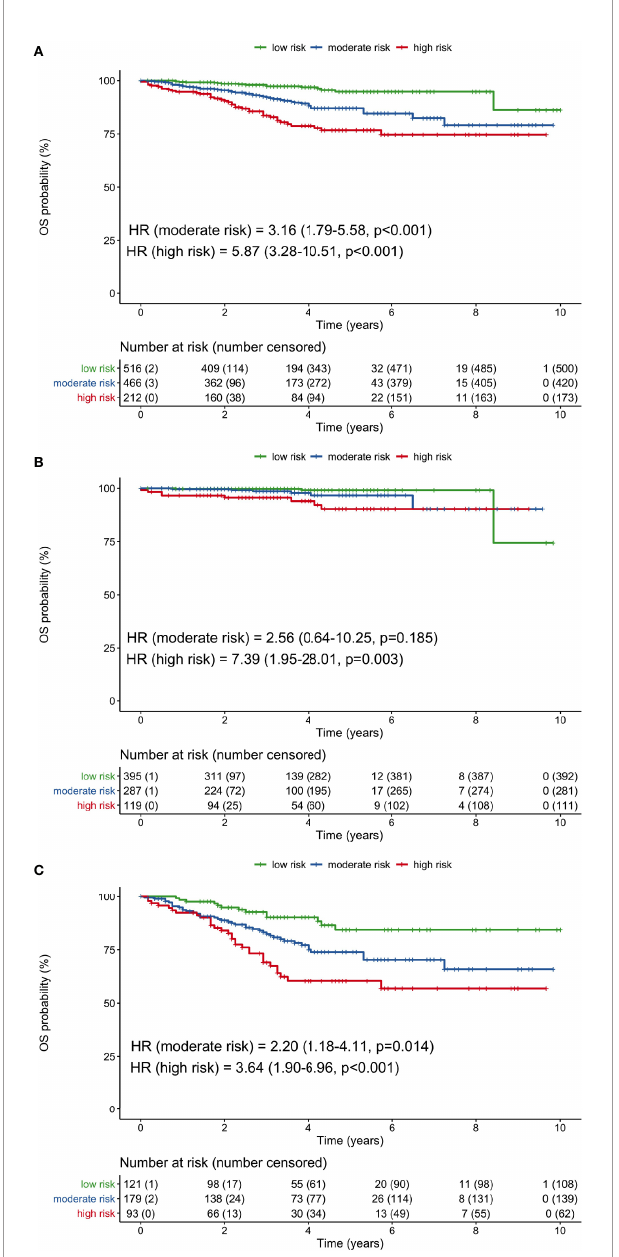
FIGURE 4 | Overall survival curves for low-, moderate-, and high-risk groups based on the combination of 1-month neutrophil and albumin values. (A) all patients, (B) stage I patients, (C) stage II/III patients. (HR, hazard ratio; OS, overall survival).